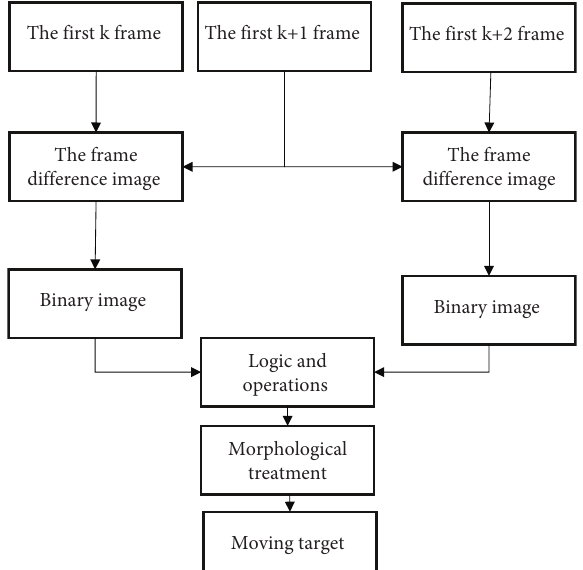
Figure 3: Principle block diagram of